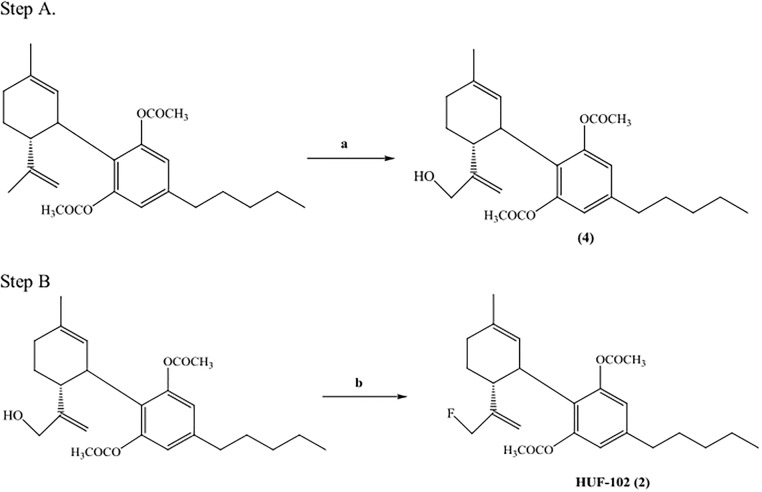
Synthesis of HUF-102(2).Reagents and conditions: (a) SeO2, t-BuOOH, CH2Cl2, r.t; (b) DAST, CH2Cl2, 0°C.